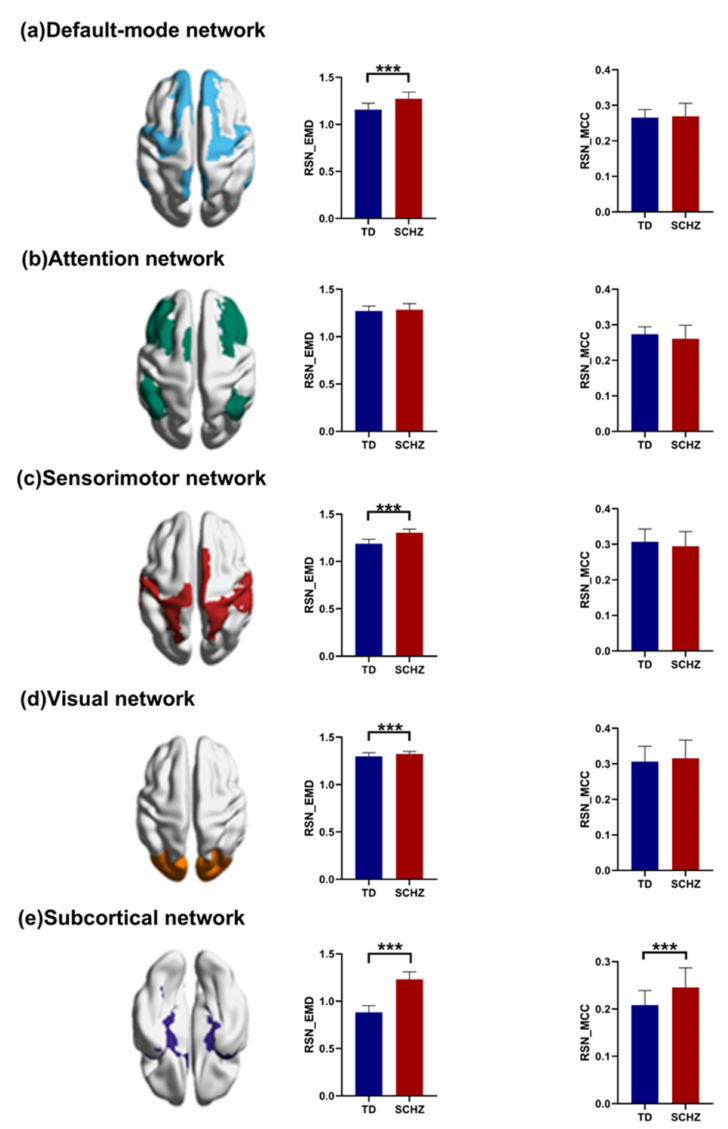
Figure 7. The differences in the entropy of the multiplex degree (EMD) and multilayer cluster- ing coefficient (MCC) at the RSN level between controls and patients with schizophrenia (SCHZ). *** indicates p =